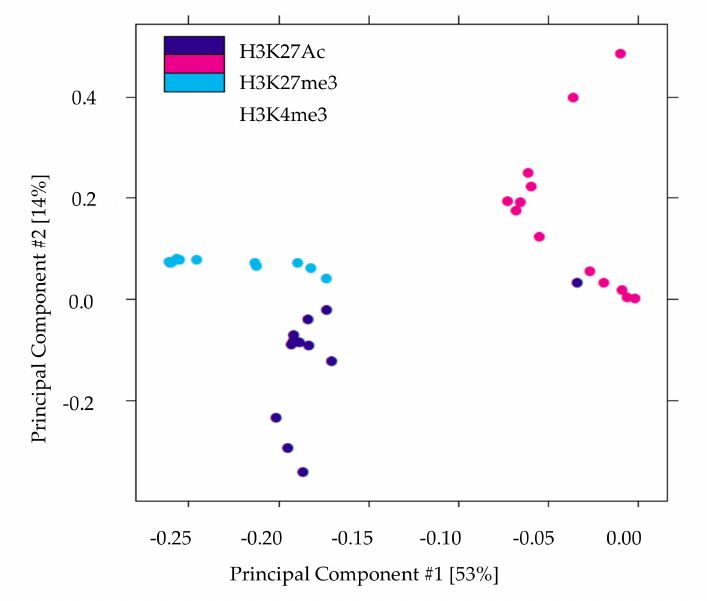
Figure 1. Principal components analysis of histone modifications in islets demonstrates that the three histone marks clearly separate. The X-axis (Comp1) represents 53% of the variability between samples and the Y-axis (Comp 2) represents 14% of the variability between